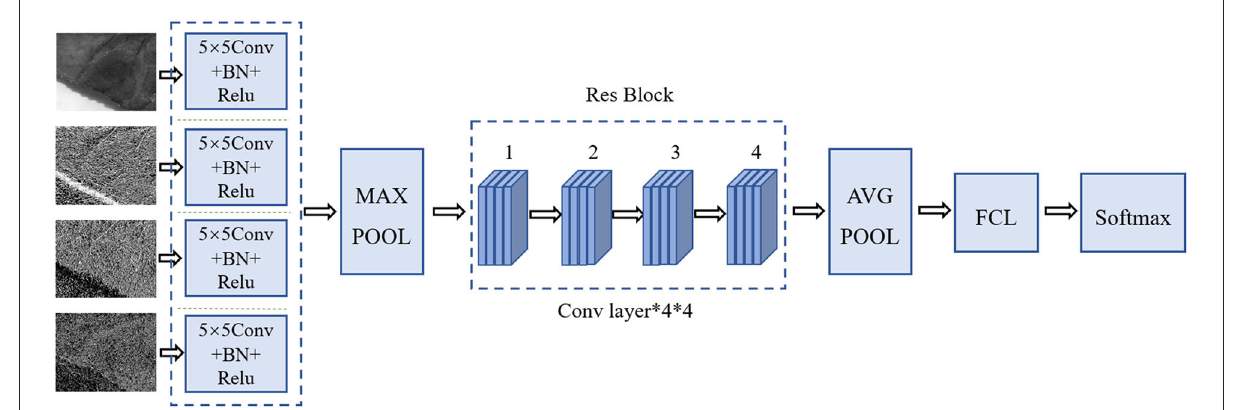
FIGURE6 Structure of F-RNet.